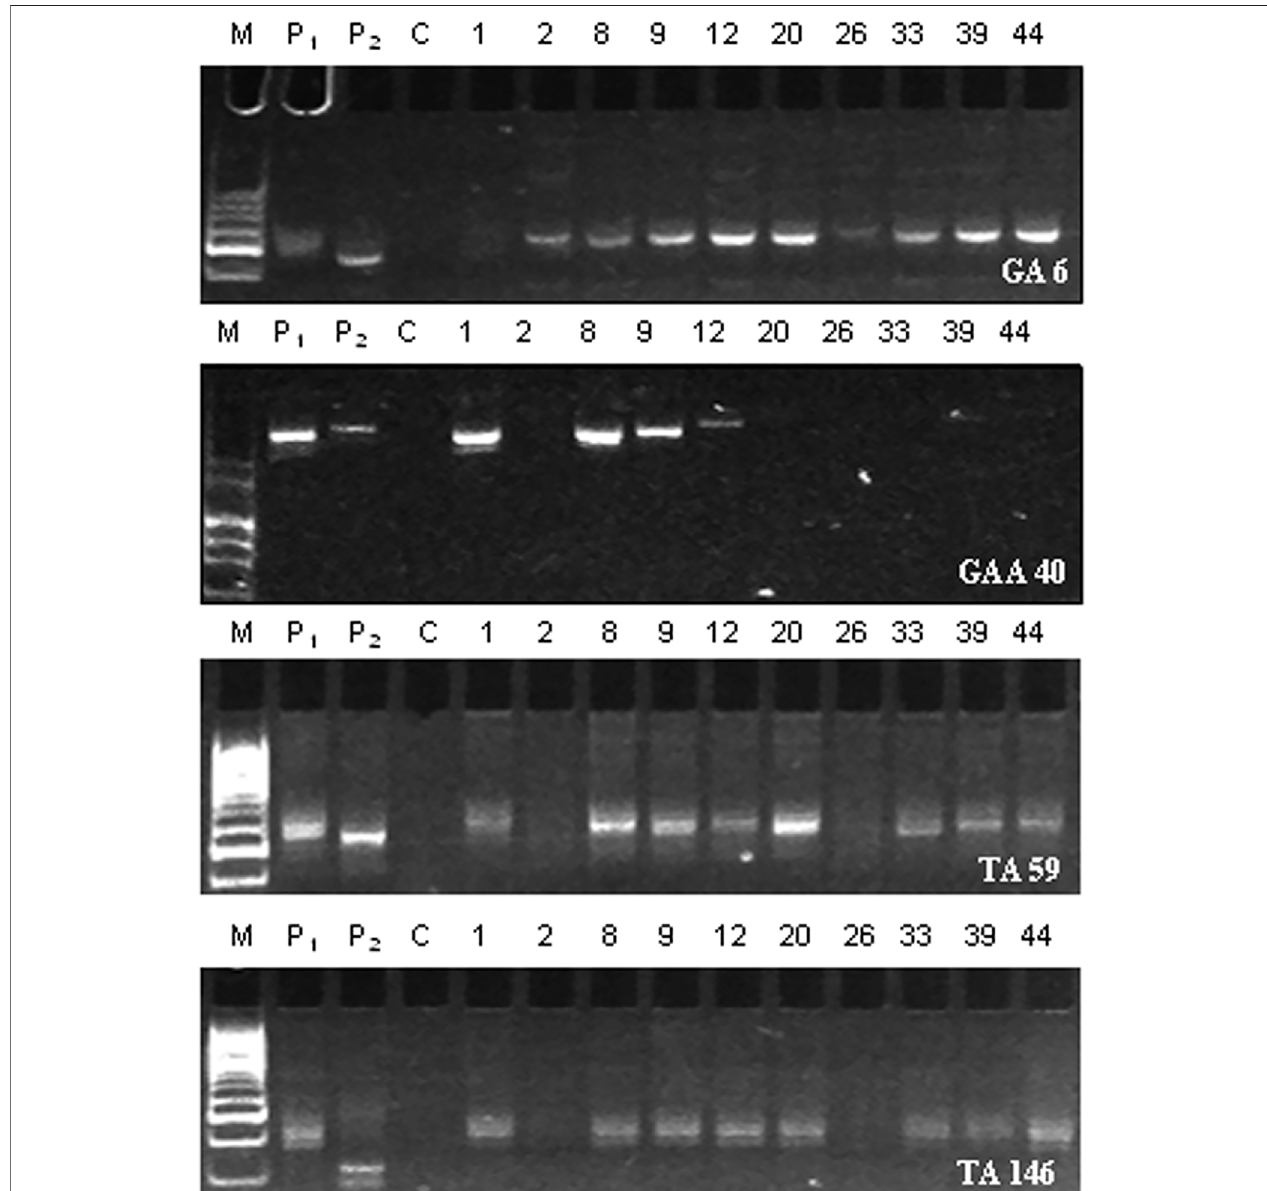
FIGURE 2 | SSR ampli fi cation pro fi les of BC 2 F 2 plants using polymorphic markers, namely, GA 6, GAA 40, TA 59, and TA 146. P 1 indicates non-transgenic recipient parent PBG7; P 2 represents transgenic donor parent BS 100E; C refers to control PCR reaction without template DNA; the numbers 1, 2, 8, 9, 12, 20, 26, 33, 39, and 44 denote BC 2 F 2 plants; and M represents 50 bp DNA ladder (Cat. No. DM1100, SMOBIO Technology, Inc.,